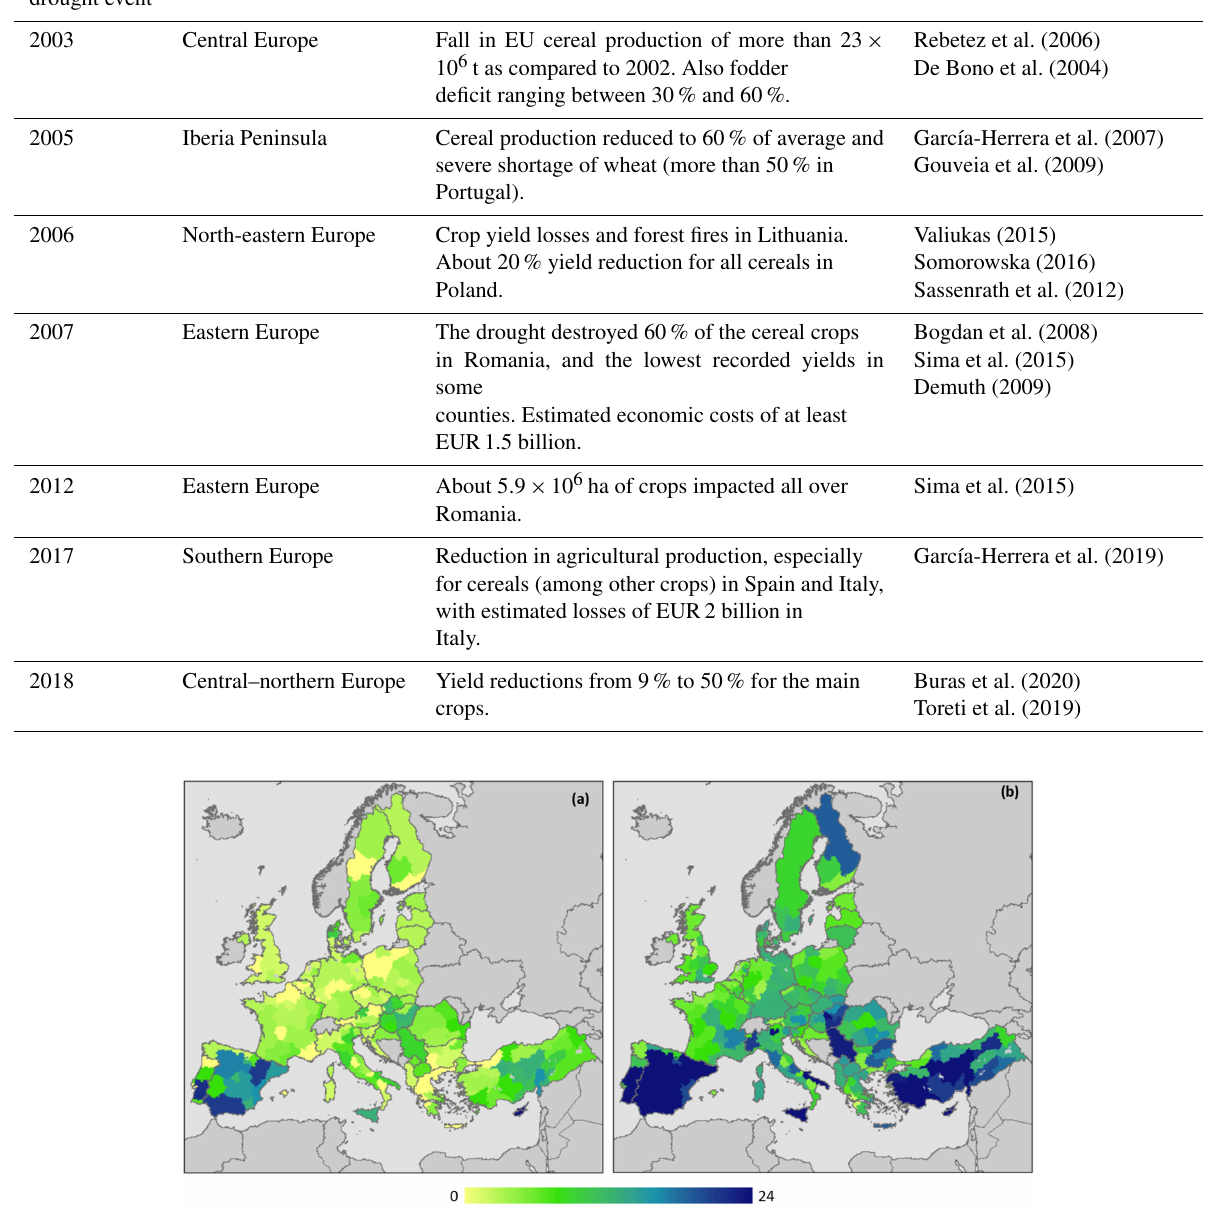
ning of October of the previous year) is part of the maximum homogeneous period in about 20 % and 50 % of the regions, for F p + and F + , respectively. It is worth noting that about 21 % of the NUTS 2 regions do not have a period (minimum 2 consecutive dekads) with F p + =